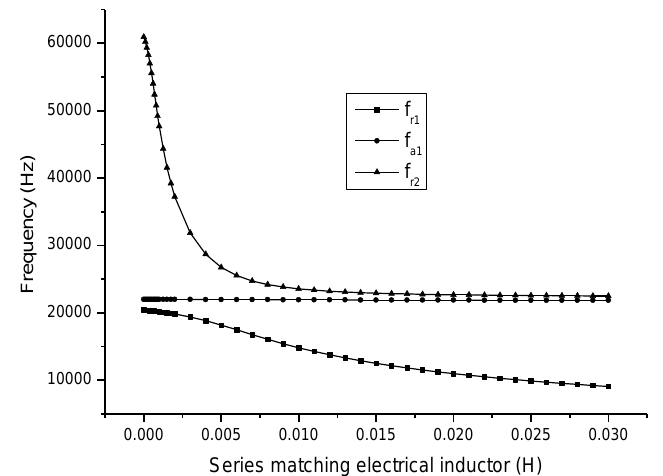
Figure 8. Theoretical relationship between the resonance/anti-resonance frequency and the series matching inductor.